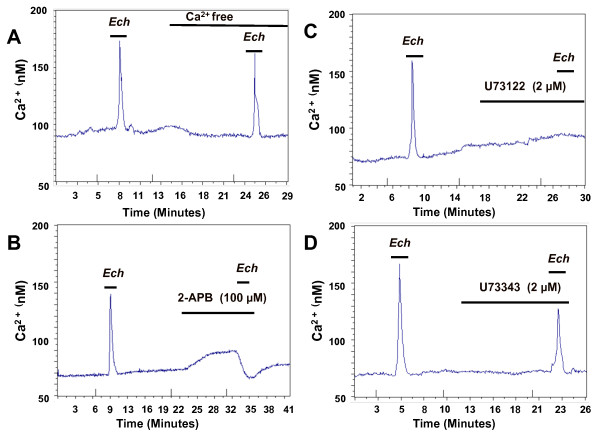
Transient increase in cytosolic Ca2+ concentration in HEK293 cells induced by E. purpurea root ethanol extracts is associated with Ca2+ release from the IP3-sensitive intracellular store and the PLC pathway. (A) Kinetic changes of [Ca2+]i in HEK cells in response to repeated applications of Echinacea extract (100 μg/ml) in normal (2 mM Ca2+) and Ca2+-free (EDTA-chelated) solution. Removal of Ca2+ from media does not affect the Echinacea-evoked response when compared to the control (without Ca2+ removal) (p < 0.001), indicating the response may be associated with the release of internal Ca2+ stores; (B) Transient increase in cytosolic Ca2+ concentration evoked by Echinacea can be abolished by 10 min pretreatment of cells with 100 μM of 2-APB, an IP3 receptor antagonist; this effect was significant (p < 0.001) as compared to the control (without pretreatment by 2-APB); (C) Transient increase in cytosolic Ca2+ concentration evoked by Echinacea can be abolished by a 10 min pretreatment of cells with 2 μM U73122, a PLC inhibitor, indicating PLC may be required for the response; this effect is significant (p < 0.001) as compared to the control (without treatment by U73122). (D) Transient increase in cytosolic Ca2+ concentration evoked by Echinacea cannot be abolished by a 10 min pretreatment with 2 μM U73343, an inactive analog of U73122. The effect of U73343 was not significant (p > 0.05) when compared to the control (without treatment of U73343). Echinacea treatment time in this set of experiments was 2 mins. Data are average traces of at least 20 cells in one experiment representative of three independent experiments.